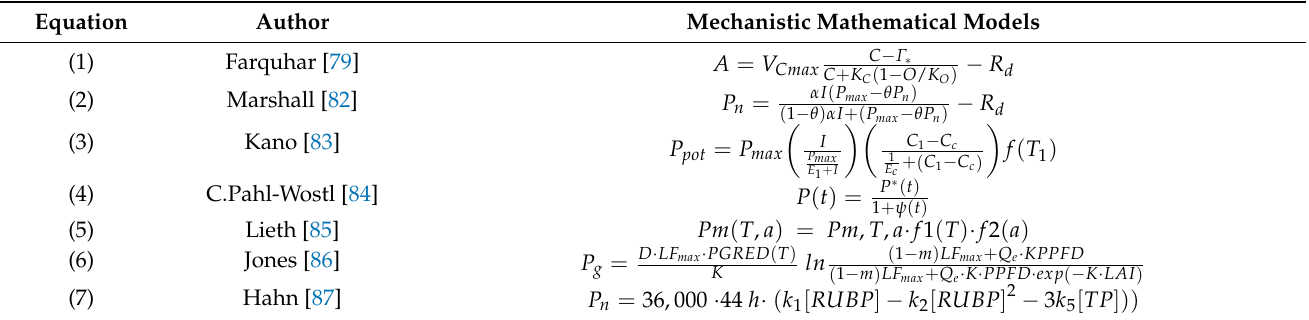
Table 2. Model equations for estimating